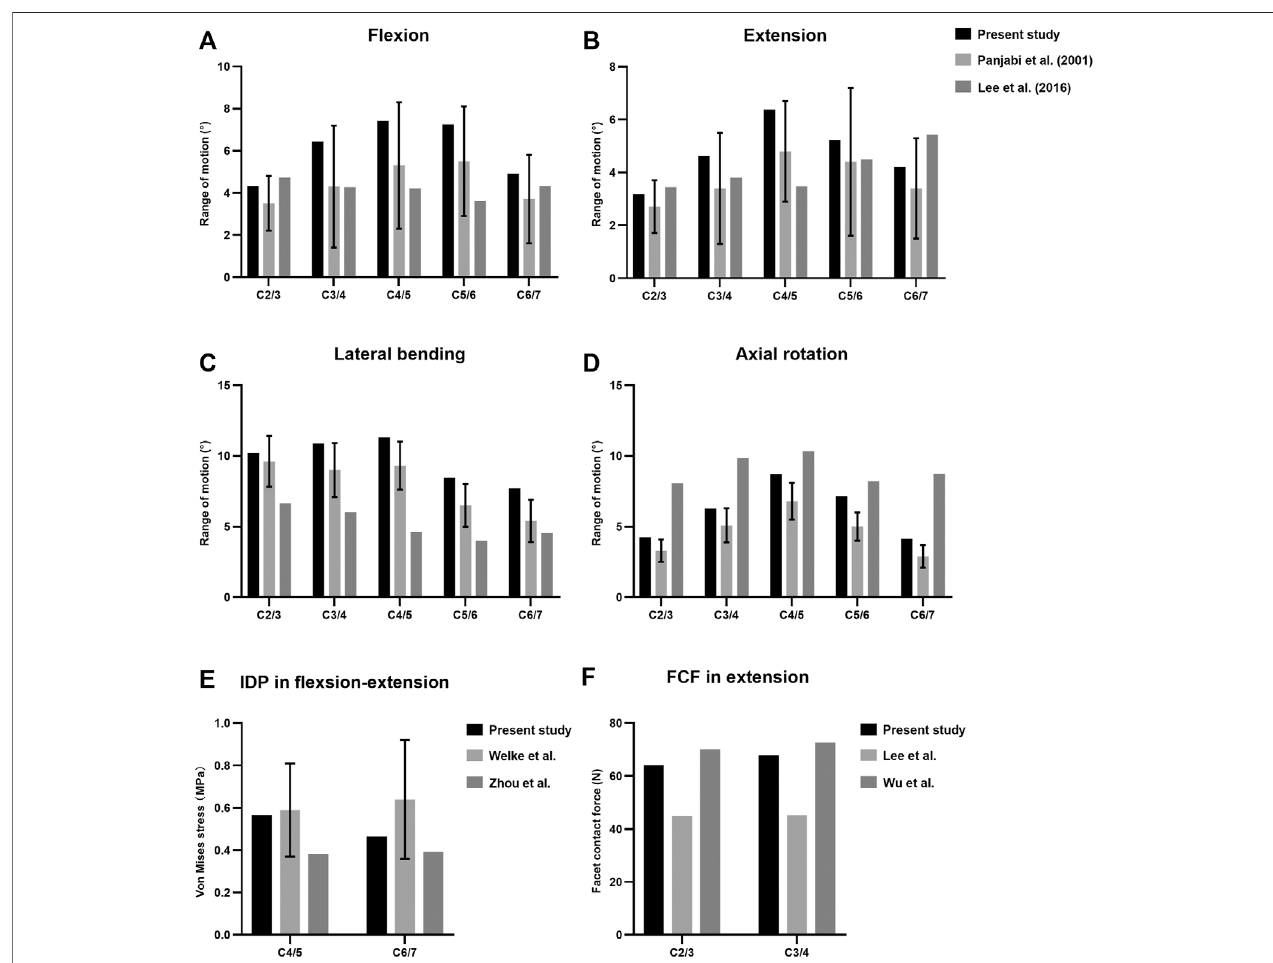
FIGURE2| Comparison ofthepredicted ranges ofmotion(ROMs) (A – D) ,intradiscalpressure(IDP) (E) and facetcontactforces(FCF) (F) withpublished literature.